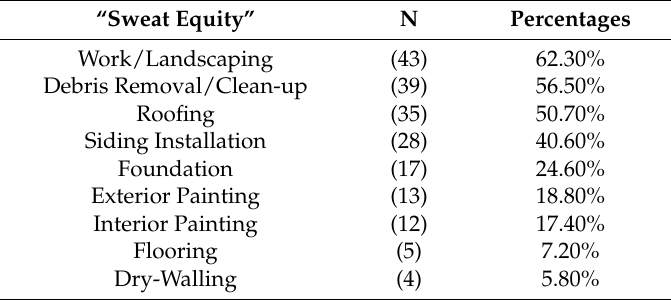
Table 15. “Sweat Equity” contributions made by Houston Habitat Homeowners Respondents.